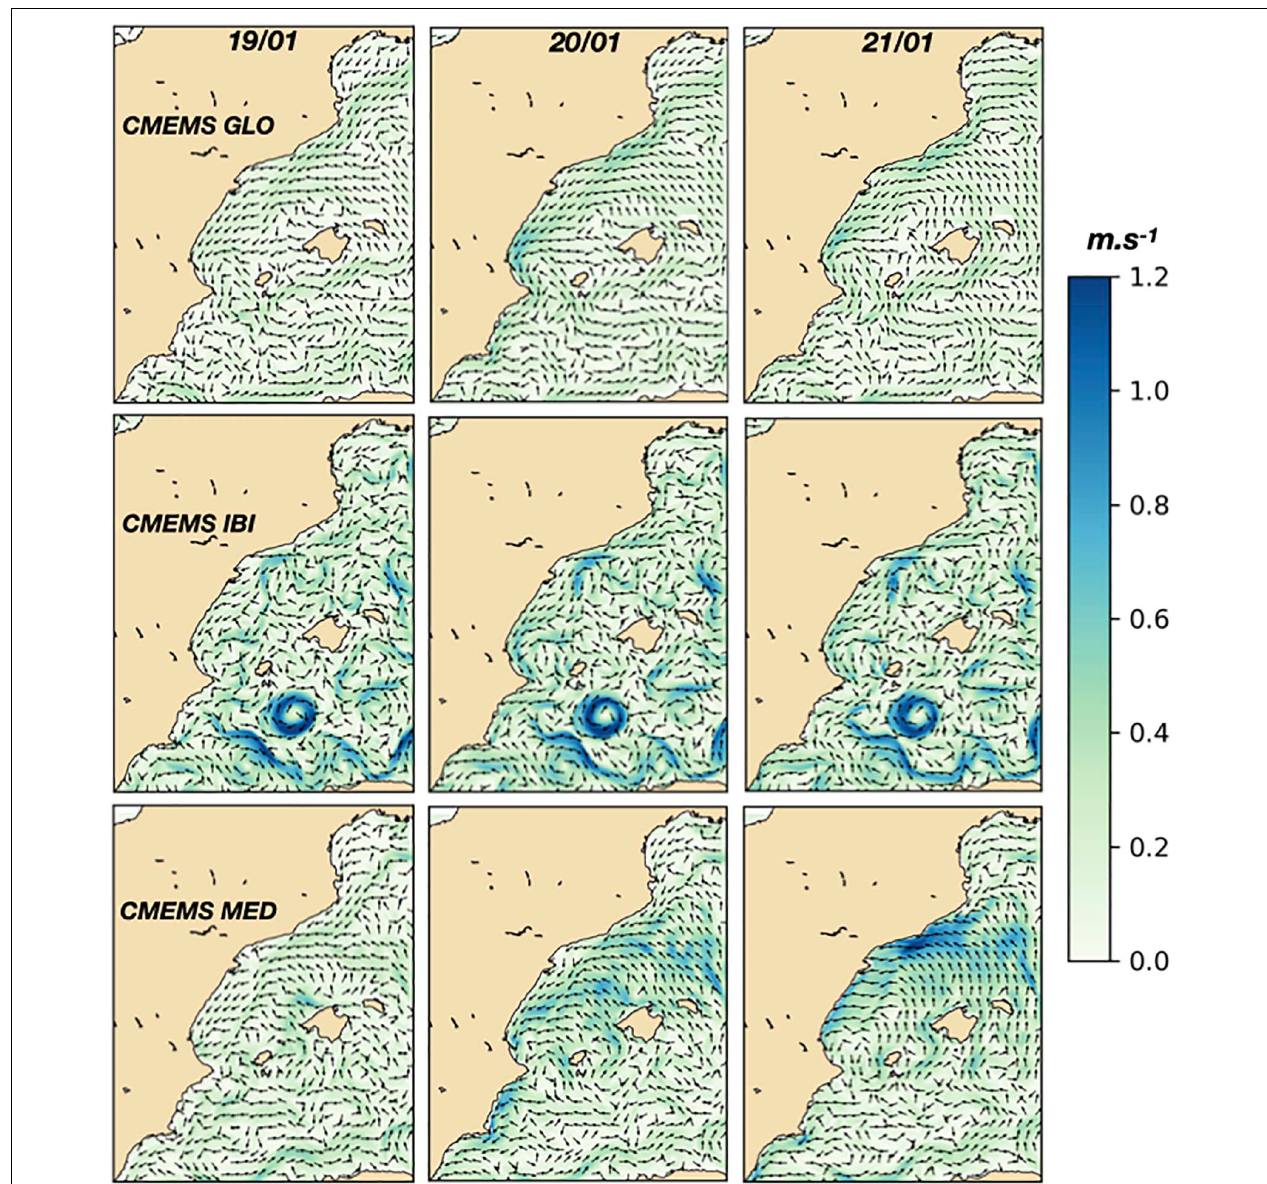
FIGURE 4 | CMEMS GLO (top), IBI (middle), and MED (bottom) operational forecasts of surface currents (in m.s - 1 ; normalized vectors indicate current direction) in the area for the 19th (left), 20th (middle), and 21st (right) of January